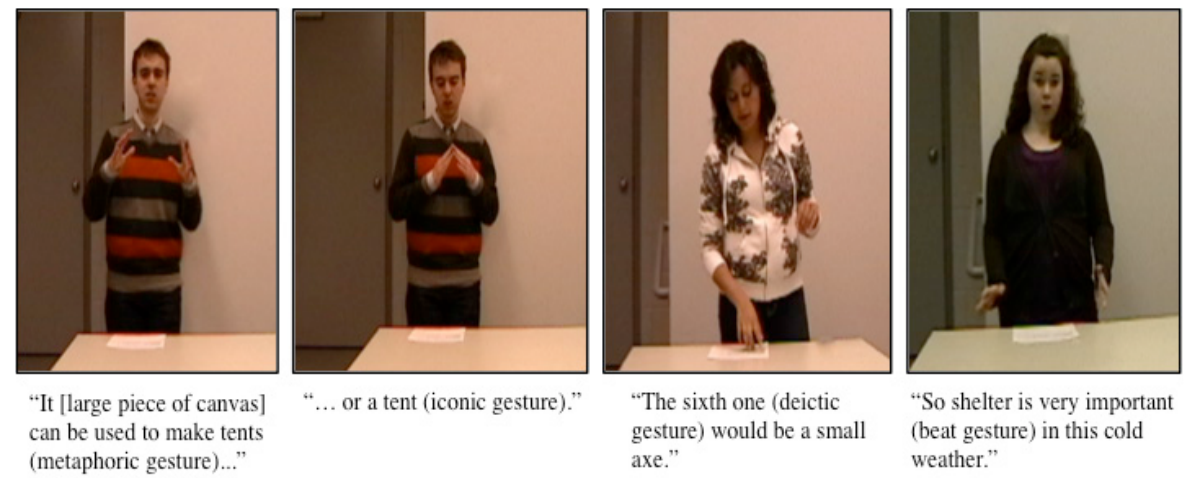
Figure 3. Screenshots of the four gesture